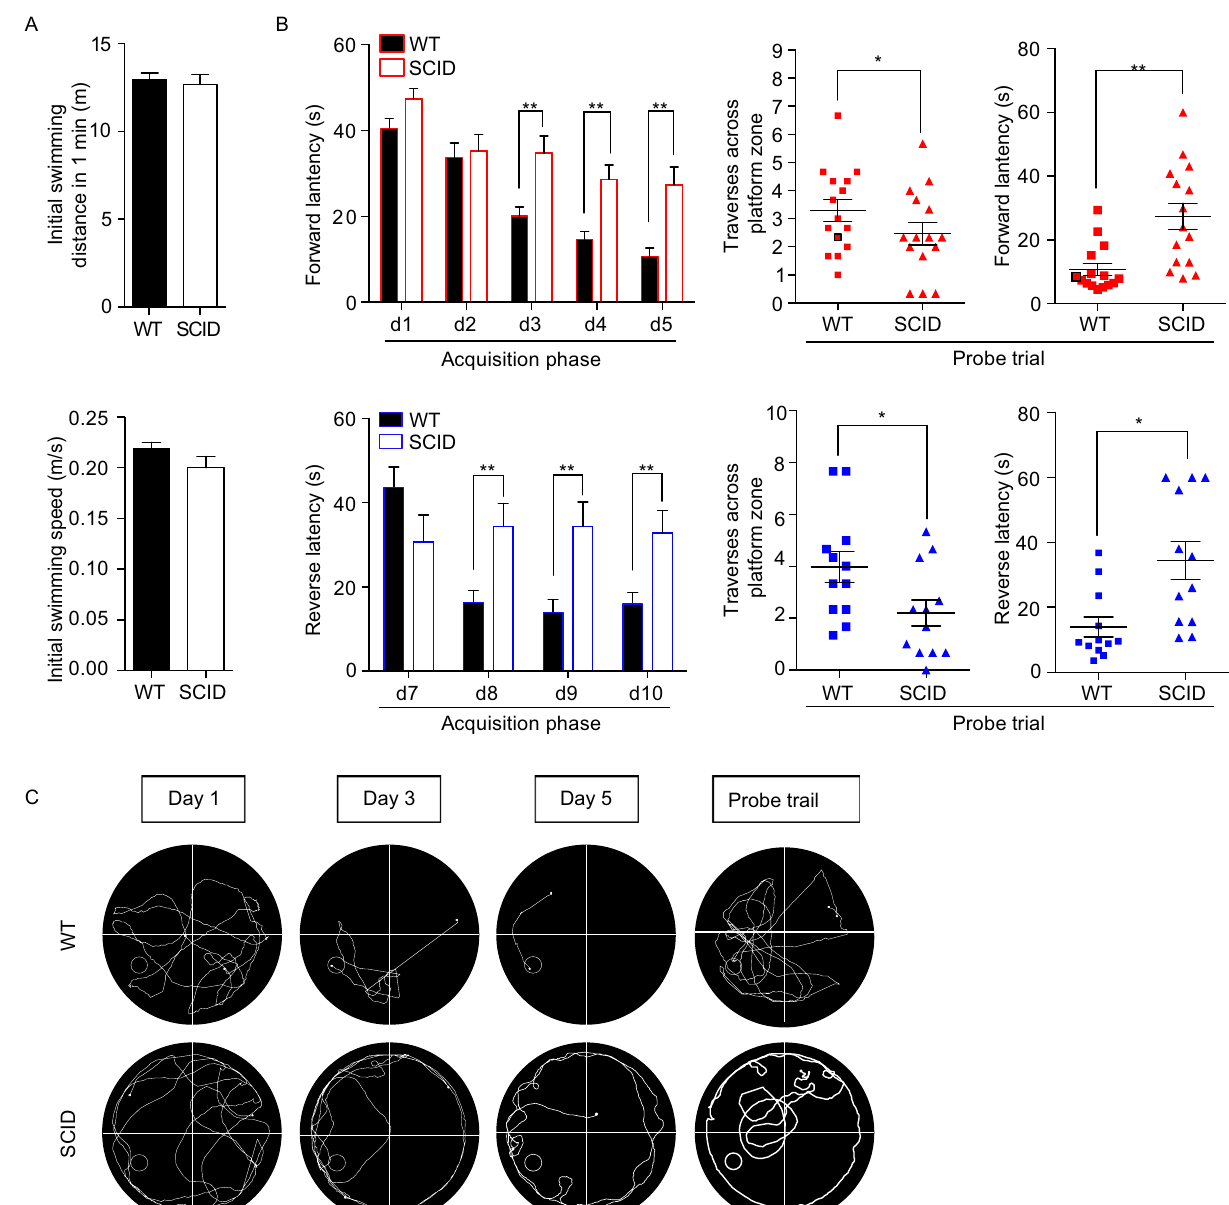
Figure 6. Uninjured SCID mice showed worse behavior performance in MWM. (A) The test of initial swimming distance (m) and swimming speed (m/s) before training showed no signi fi cant differences between two genotypes (mean±SEM; n =15, P >0.05, unpaired Student ’ s t -test). (B) Upper panels (in red) shows the escape latency for mice to reach the hidden platform during forward acquisition training phases, as well as traverses through the platform zone and the latency to fi rst reach the platform zone (mean± SEM; n =15, * P <0.05, ** P <0.001, unpaired Student ’ s t -test). The lower panel (in blue) shows the exact same results in reverse test (acquisition phase and probe trial). (C) Representative swimming traces of SCID and WT mice during acquisition training phases and probe